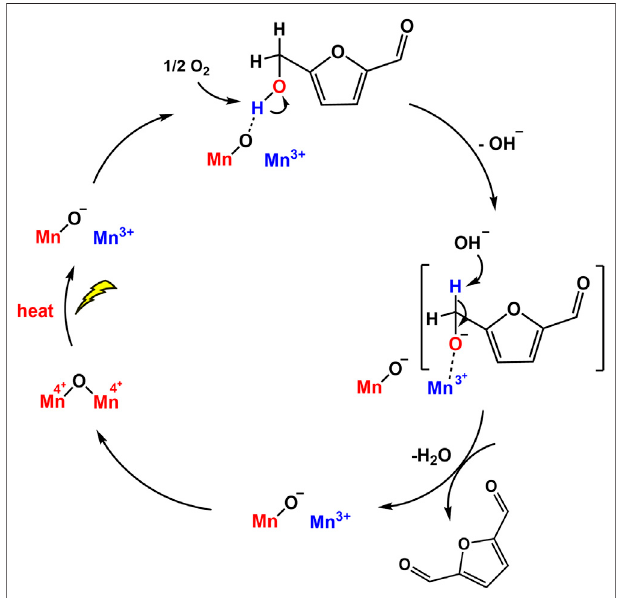
FIGURE 9 | Proposed mechanism for the photo-oxidation of HMF into DFF promoted by MnO 2 nanorods.